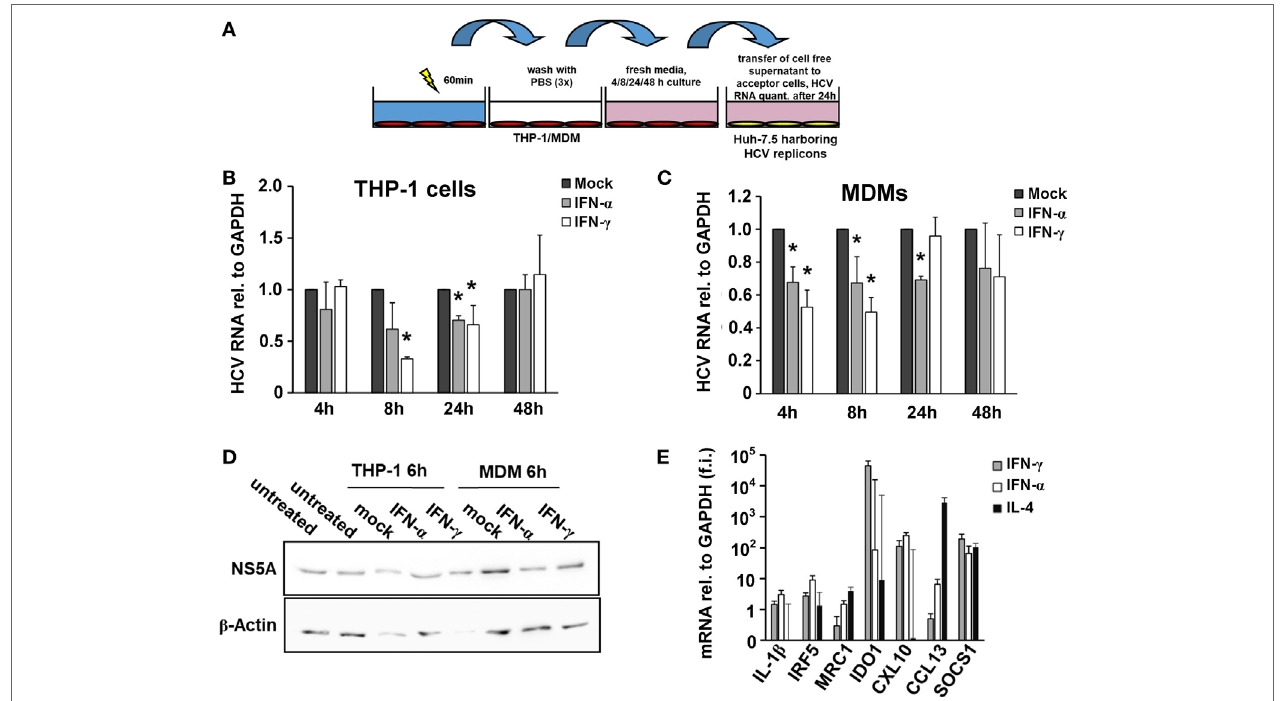
FigUre 1 | Interferon-pulsed macrophages inhibit hepatitis C virus (HCV) replication. (a) Schematic outline of the supernatant transfer experiment from macrophages to hepatoma cells harboring subgenomic HCV replicons. THP-1 cells were treated with 50 nM phorbol 12-myristate 13-acetate for 48 h to differentiate them into a macrophage-like phenotype. After 1 h of stimulation with mock, IFN- α (500 IU/ml) or IFN- γ (25 ng/ml), media were removed, and the cells were washed with PBS for three times to remove IFN entirely. Fresh media were added and collected after 4, 8, 24, and 48 h. Cell-free supernatant was transferred to hepatoma cells harboring subgenomic HCV replicons. After 24 h, cells were lysed for RNA isolation. (B,c) Relative HCV RNA replication levels of hepatoma cells harboring subgenomic HCV replicons after exposure to THP-1 (B) or MDM (c) supernatants. Maximal antiviral activities were observed 8 h after transfer of supernatants. Graphs show the mean and SE of triplicate samples taken at 4, 8, 24, and 48 h. RNA replication levels of mock-treated samples ( black bars ) were normalized to 1 and compared with IFN- α - (gray bars) or IFN- γ - (w hite bars ) treated samples. (D) Western blot analyses of HCV NS5A protein levels of hepatoma cells harboring subgenomic HCV replicons after exposure to THP-1 or MDM supernatants. (e) Phenotyping of MDMs by quantitative PCR after treatment revealed polarization toward an M1 phenotype after stimulation with IFN. Quantities of mRNAs relative to GAPDH of IL-1 β , IRF5, MRC1, IDO1, CXCL10, CCL13, and SOCS1 were assessed and expressed as fold induction (f.i.) relative to mock for M1/2 phenotypes. Graphs show the mean and SE of triplicate samples stimulated with IFN- α ( white bars ), IFN- γ ( gray bars ), or IL-4 ( black bars ) (* P <